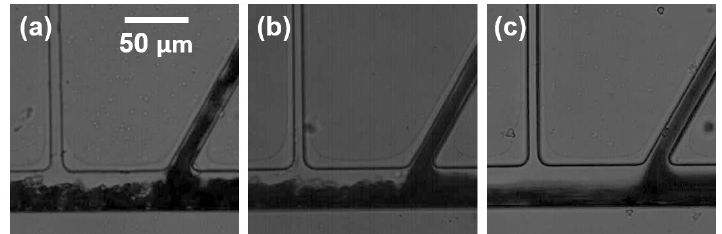
Figure 5. Typical examples for plasma separation from 40% hematocrit blood samples with the bifurcation angle of θ = 60° at 20 μ L/min ( a ); 40 μ L/min ( b ) and 80 μ L/min ( c ) of flow rate ( Q inlet ).